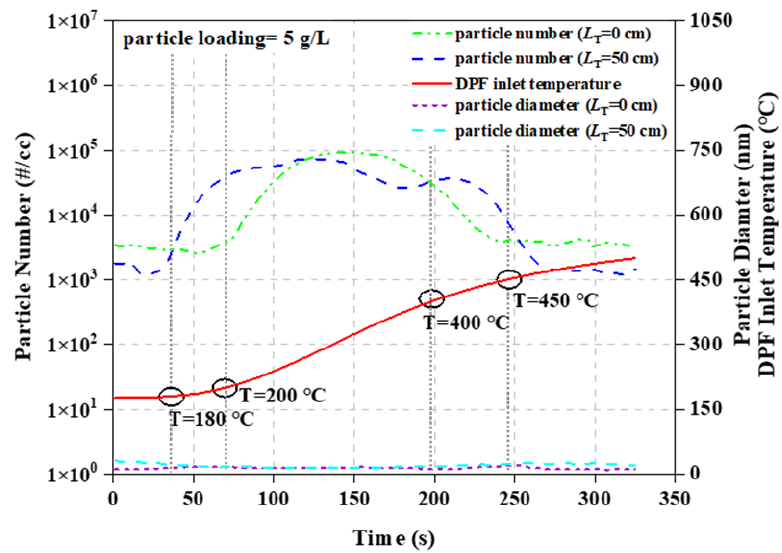
Figure 3. Particle emission characteristics with different inlet transition section lengths during heat- ing.